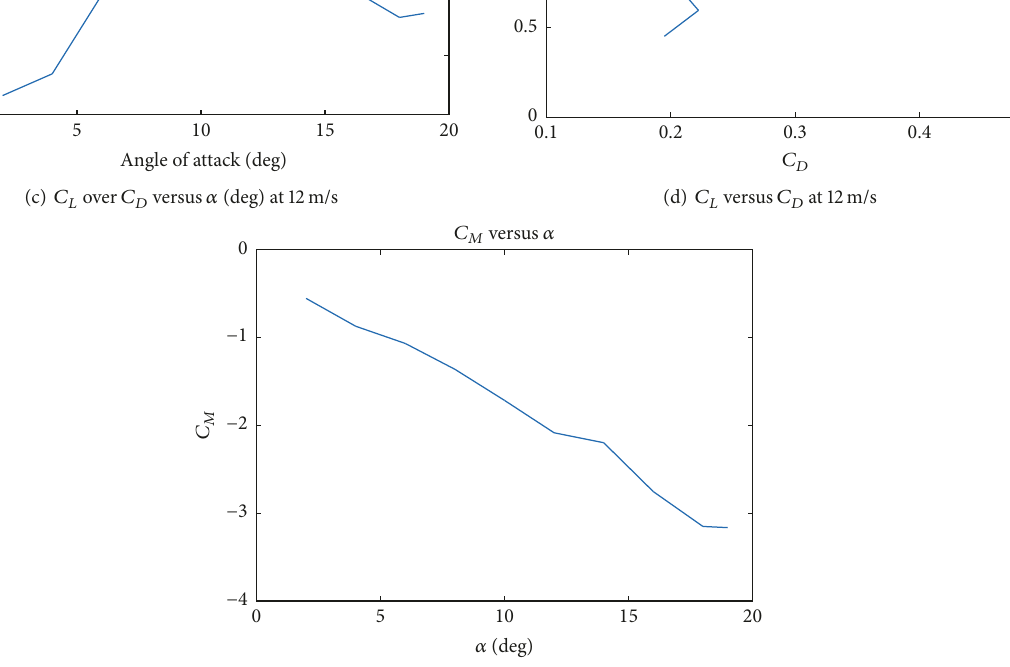
Figure 10: Aerodynamic properties of the FMW mini-UAV at 12m/s wind